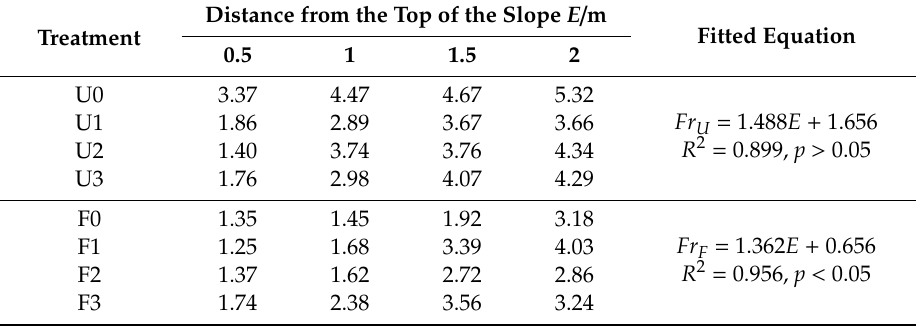
Table 6. Variations of Froude number with the distance from the top of the slope. Distance from the Top of the Slope E /m Treatment